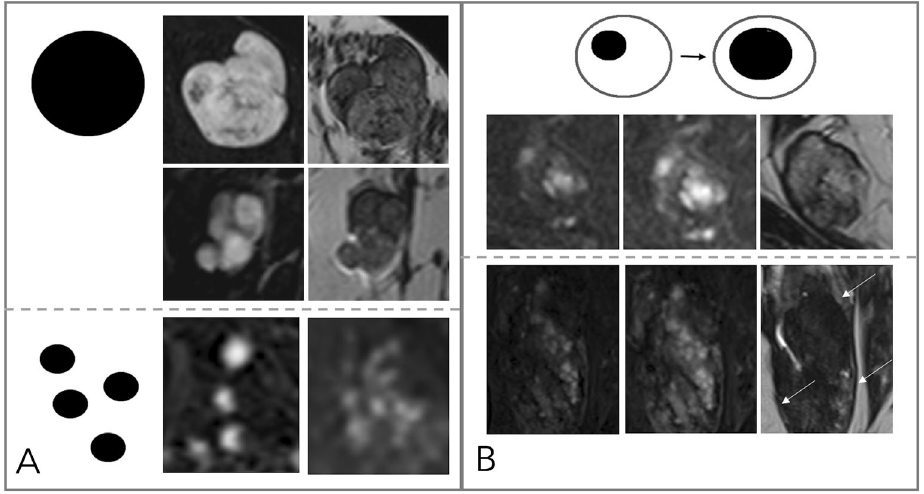
Fig. 4 Diagnostic criteria: non-suspicious internal enhancement patterns. A: Homogeneous enhancement suggests benign lesions. Note that even a homogeneous enhancing lesion may show areas of lesser or absent enhancement due to septae and fibrotic parts [A, upper two rows, each early enhanced subtractions (left) and T2w (right)]. Homogeneity is more difficult to assess in non-mass lesions (A, lower row) and includes homogeneous internal morphology. Therefore, this feature was referred